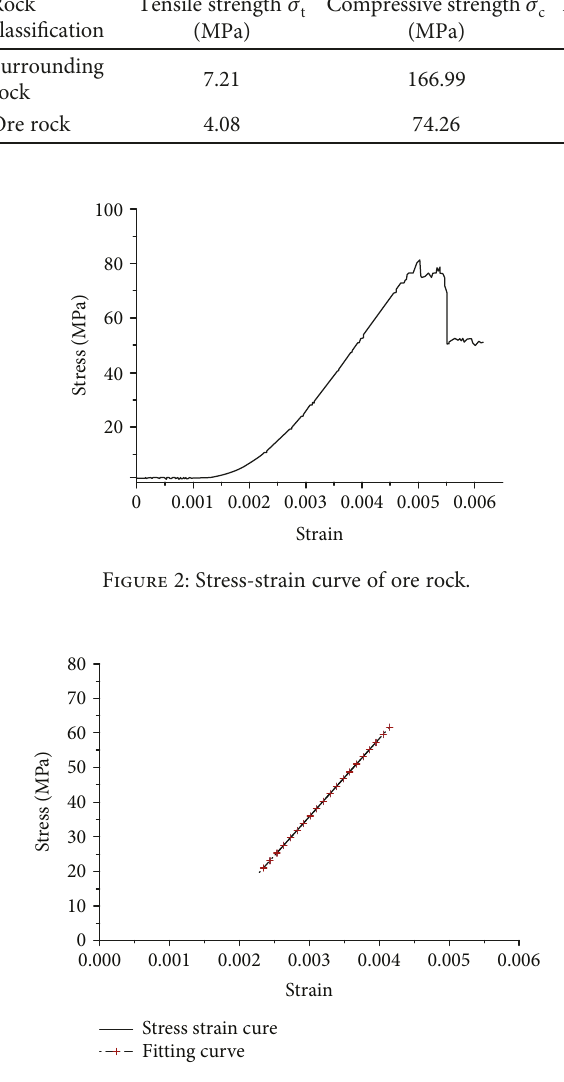
Figure 3: Fitting diagram of elastic modulus of ore rock.